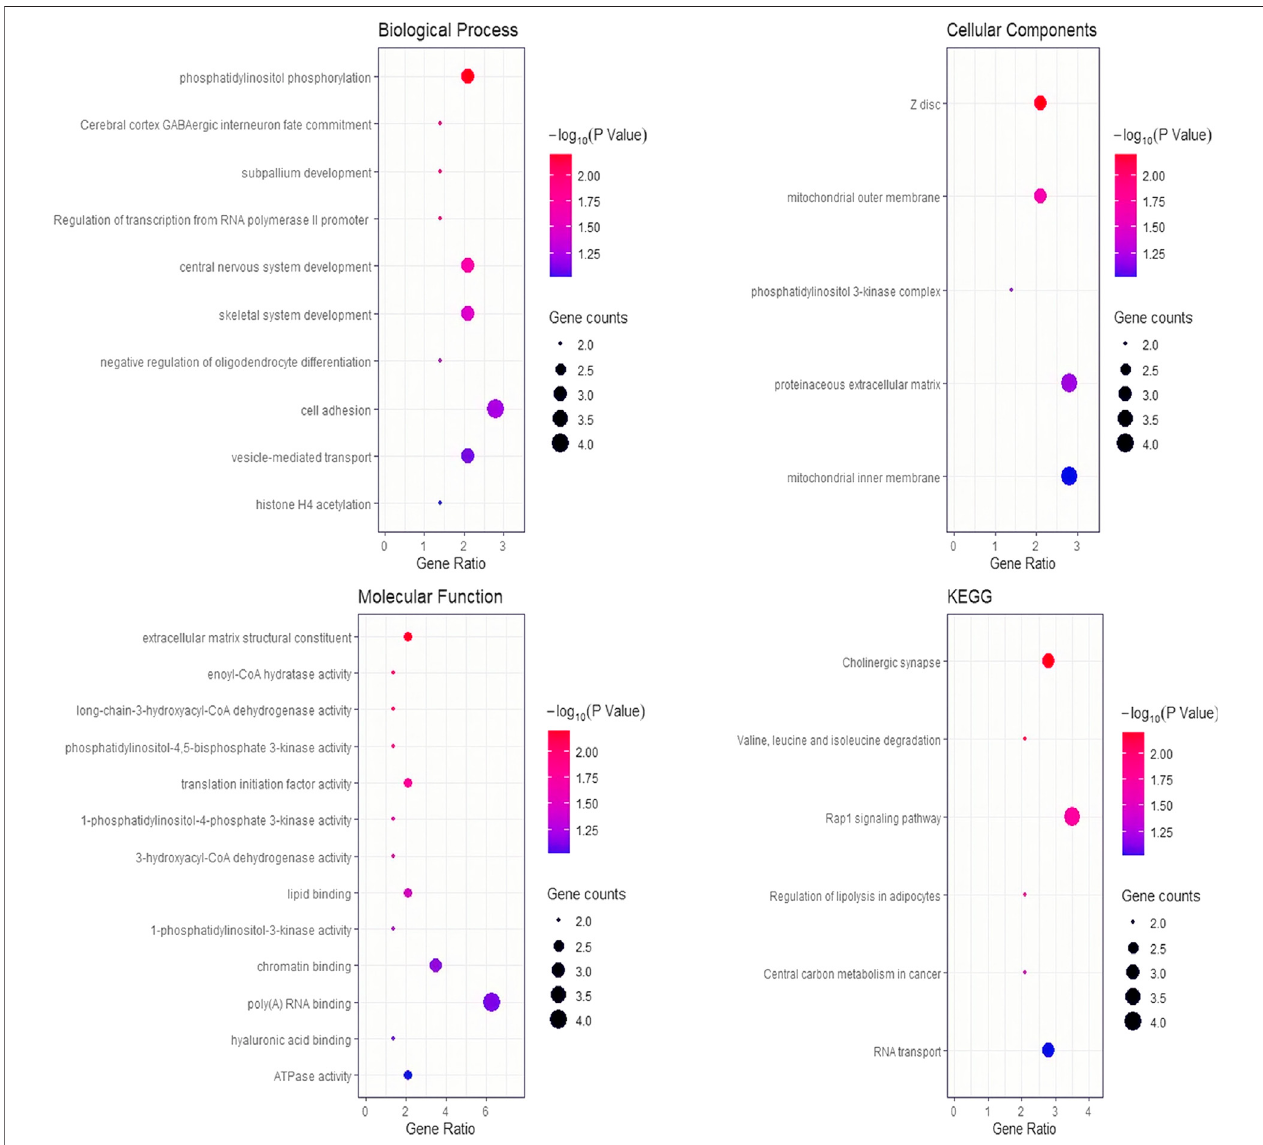
FIGURE 3 | Bubble chart of GO terms and KEGG pathways for the enrichment analyses. The y -axis represents the gene functions or pathways and the x -axis is a ratio between the number of candidate genes that are annotated to the target terms to the number of background genes.